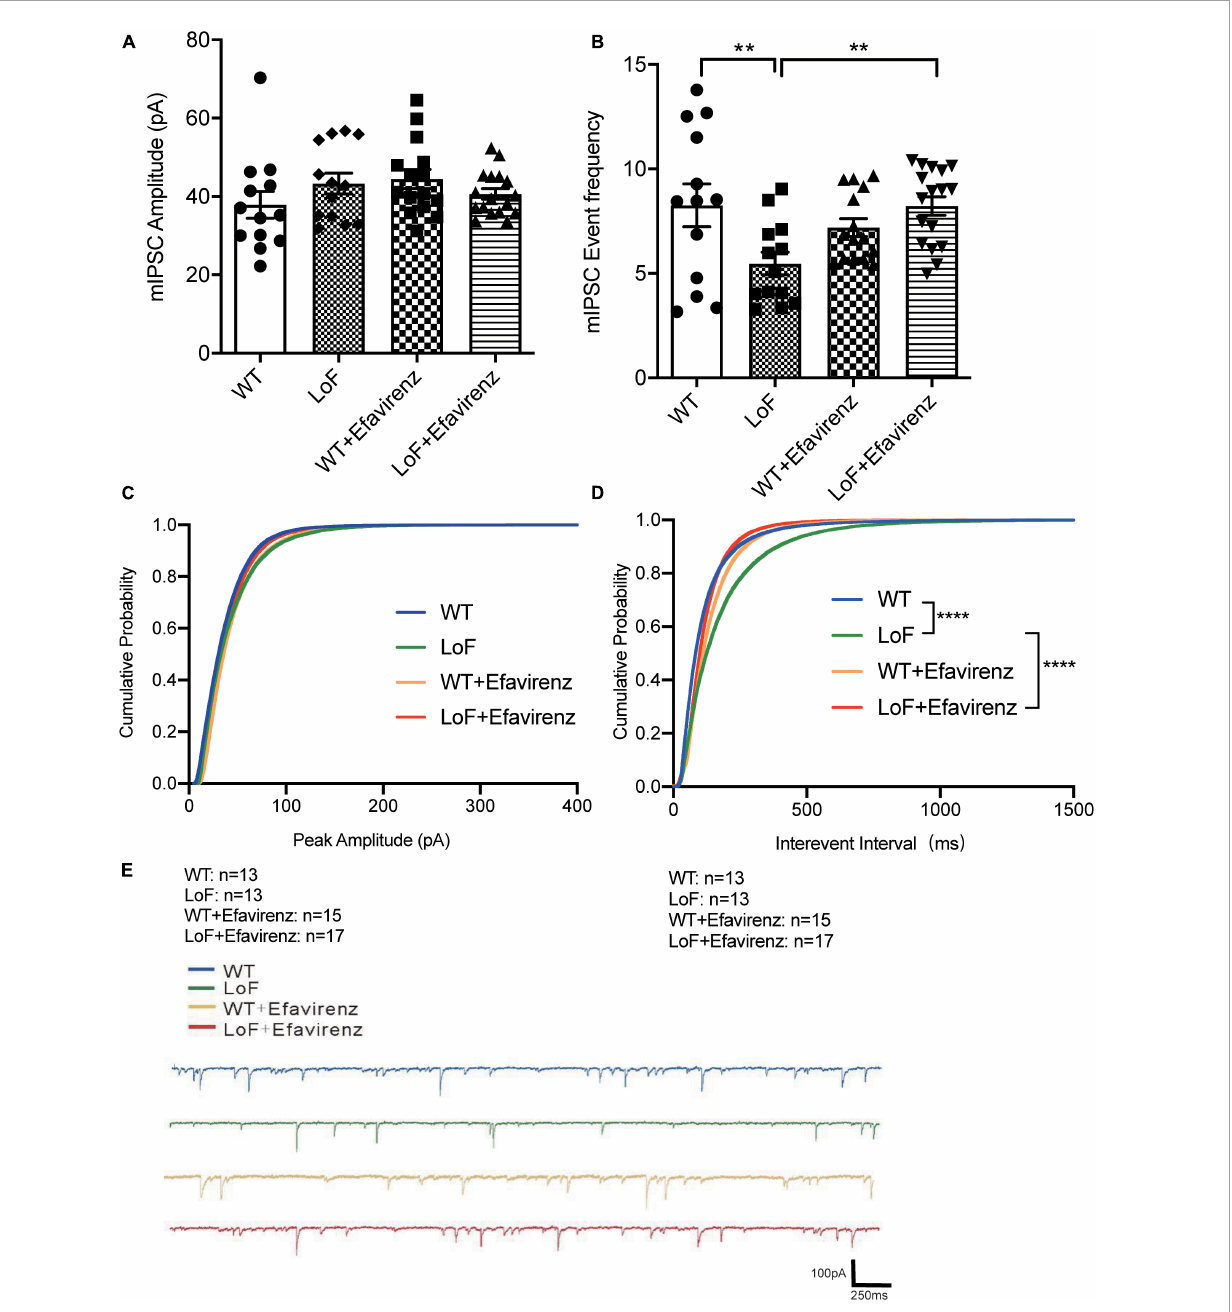
FIGURE6 Comparisons of the amplitude and event frequency of mIPSC in hippocampal CA1 region of mice. Mouse brain slices were used for recording mIPSC in the hippocampal CA1 region. (A) Amplitude, (B) event frequency, (C) cumulative probability of peak amplitude, (D) cumulative probability of inter-event interval, and (E) the typical mIPSC in each group. ** P < 0.01; **** P <